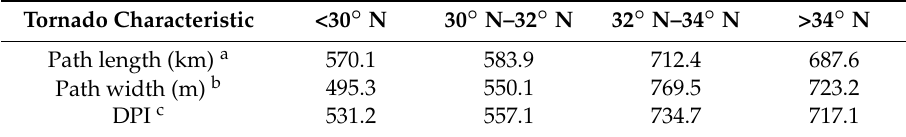
Table 2. Mean ranks used in the Kruskal-Wallis tests for the <30 ◦ N, 30 ◦ N–32 ◦ N, 32 ◦ N–34 ◦ N, and >34 ◦ N regions. Results of the Kruskal-Wallis tests are located below the table. Post-hoc pairwise comparisons indicate that, for all three variables, the mean ranks in the 32 ◦ N–34 ◦ N and >34 ◦ N regions are significantly greater than the mean ranks in the <30 ◦ N and 30 ◦ N–32 ◦ N regions. Tornado Characteristic <30 ◦ N 30 ◦ N–32 ◦ N 32 ◦ N–34 ◦ N >34 ◦ N Path length (km) a 570.1 583.9 712.4 Path width (m) b 495.3 DPI c 531.2